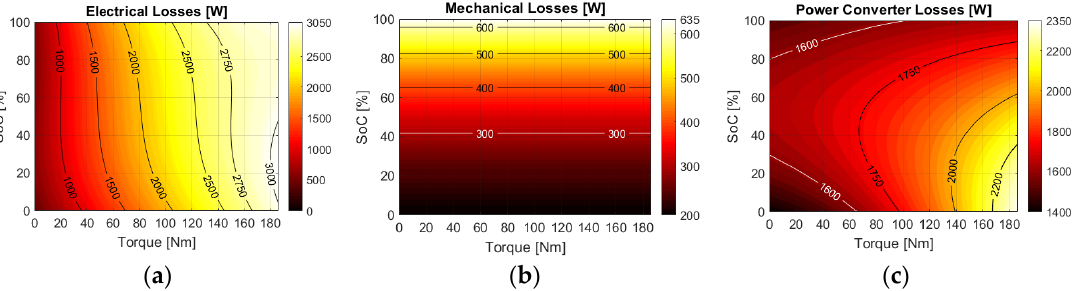
Figure 4. Main FESS losses with respect to the state of charge (SoC) and torque: ( a ) Electromagnetic; ( b ) Mechanical; ( c ) Power electronics.